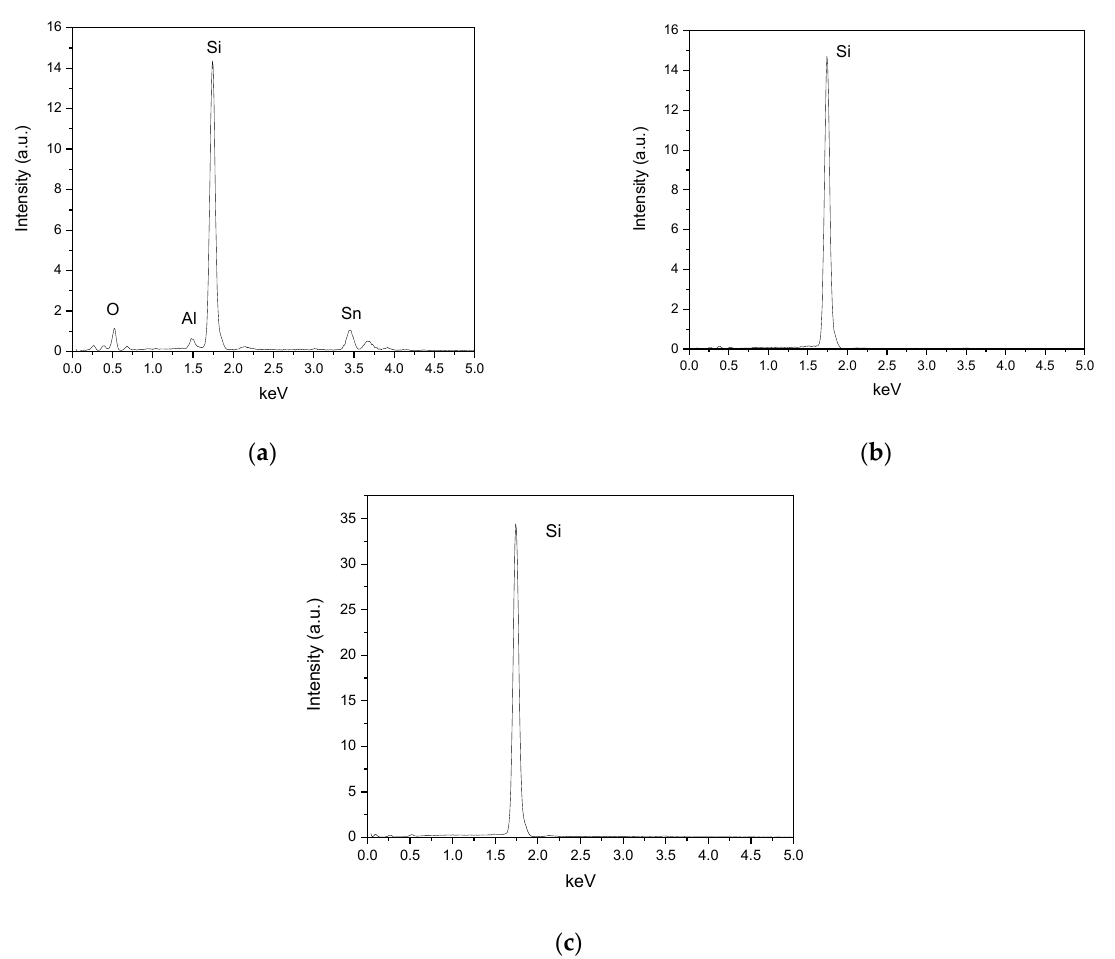
Figure 4. EDX spectra of silicon wafer particles recovered at ( a ) 1.5 h ( b ) 6 h and ( c ) 24 h etching time. Regarding the metals of interest in this work (Cu, Ag, Pb), they were obtained after the chemical treatment in the form of ions (Cu2 + , Pb 2+ , Ag + ) in the solution. The quantification of these metals was also done as a function of etching time, using the Atomic Absorption Spectroscopy technique (see Figure 5).